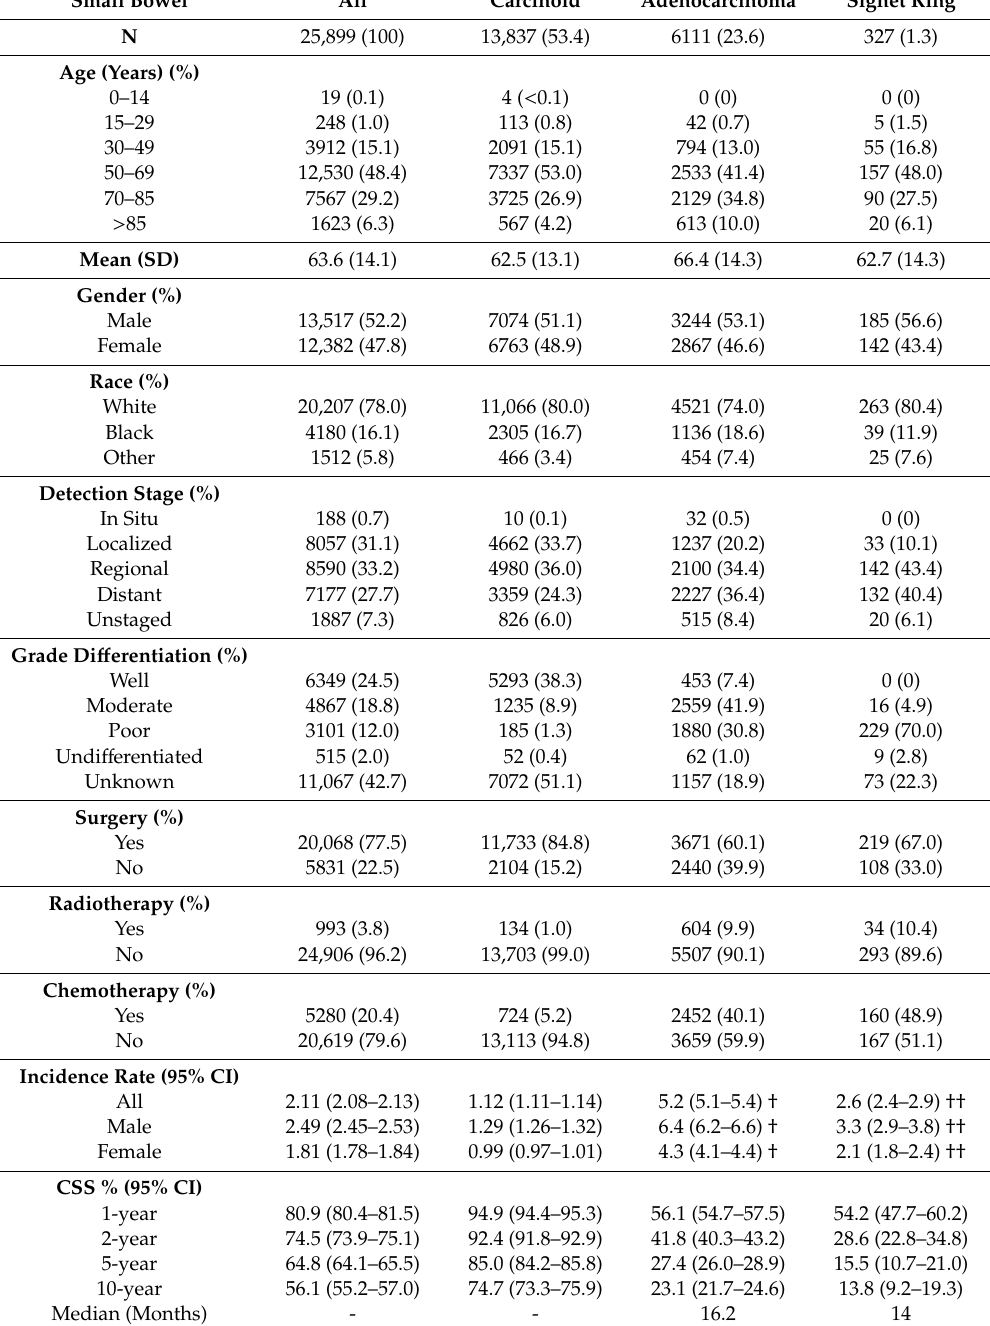
Table 21. Baseline demographics and clinical characteristics by histology for small bowel